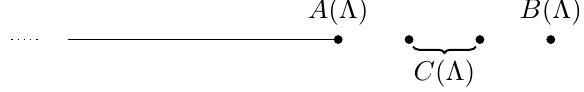
Figure 5 . The positioning of unitary highest weight representations in highest weight space. The highest weights lie on lines of the form (cid:21) = (cid:3) + z(cid:16) , and the (cid:12)gure represents the values of z 2 R that give unitary weights. On a given line, there is a semi-in(cid:12)nite line of highest weights which is allowed, and then an equally spaced set of discrete allowed values, starting at the end of the half-line, and ending after a (cid:12)nite number of